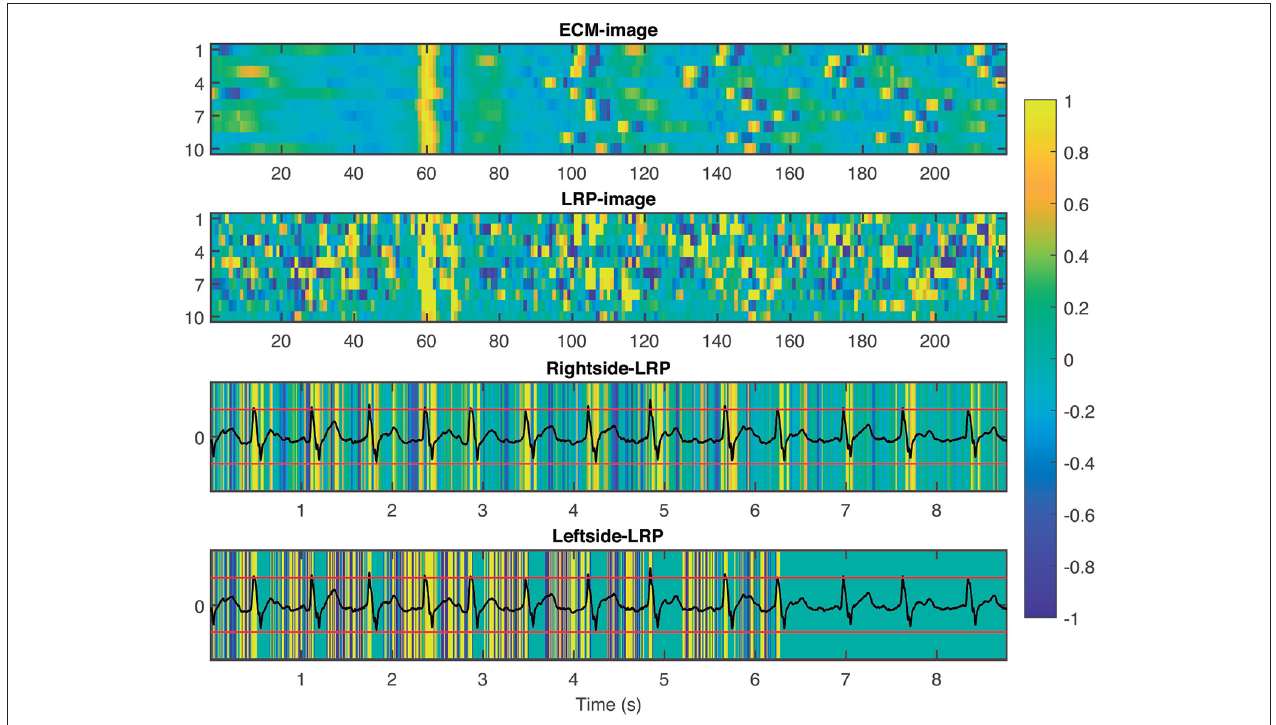
FIGURE 4 | From top to bottom : ECM-image labeled as AF and correctly classified as AF, heatmap image resulting from the LRP process, rightside-LRP, and leftside-LRP. The rightside-LRP mainly highlights the detection of the QRS complexes while the leftside-LRP captures morphological information used for the